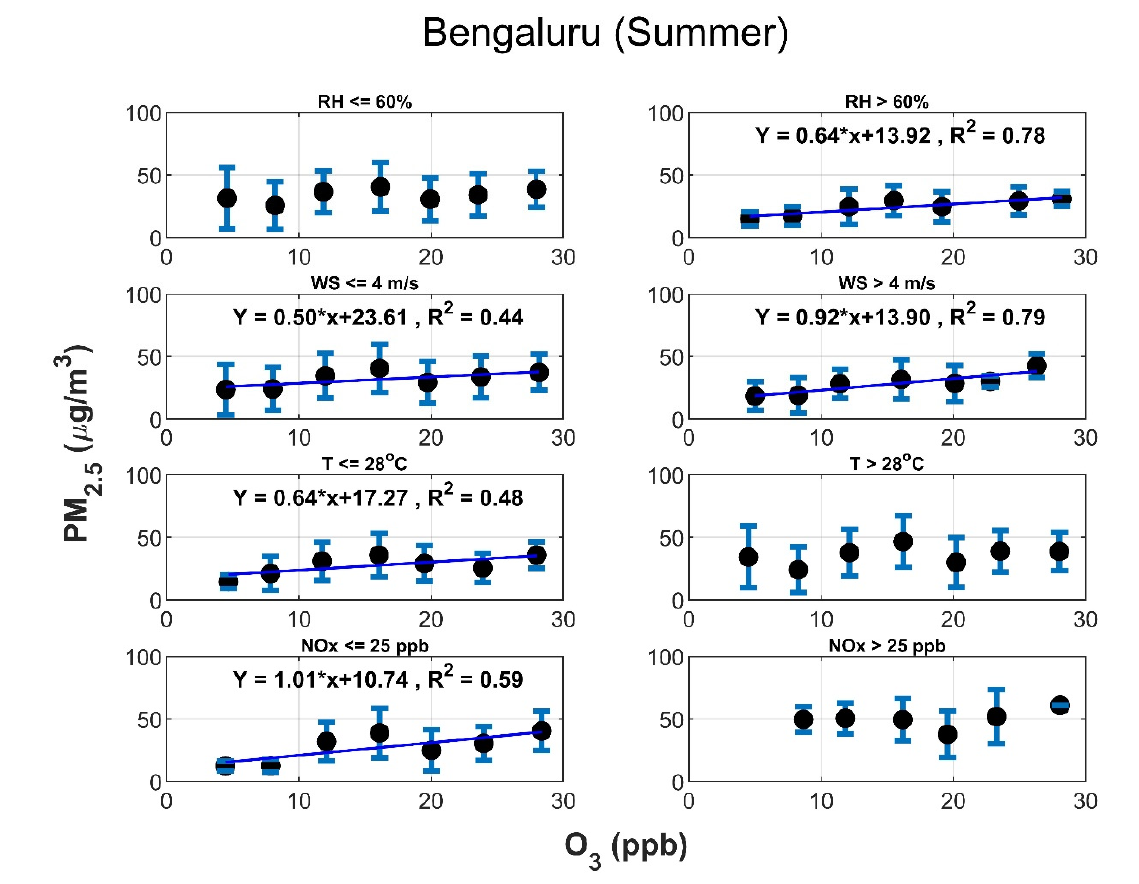
Figure 11. Dependence of PM 2.5 concentration on O 3 in Bengaluru during the summer season for different meteorological parameters.